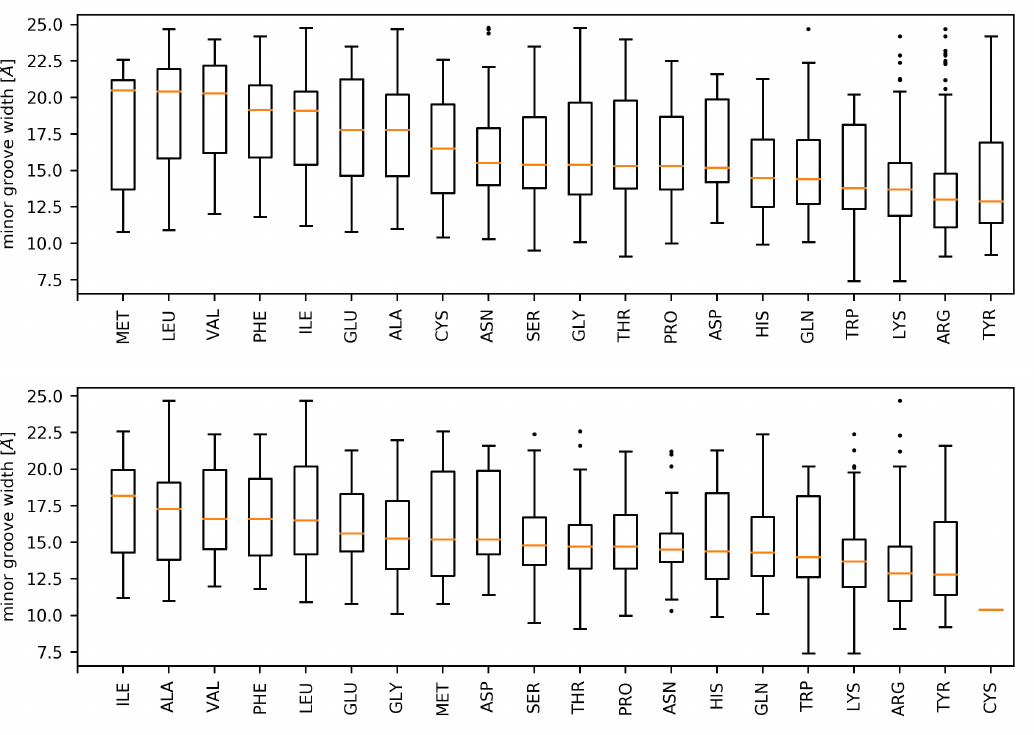
Figure 4. Distributions of DNA minor groove widths associated with the dinucleotides bound by the respective amino acids (top: DS1, bottom: DS2). Amino acids are sorted in descending order according to the associated median minor groove width. Whiskers of the boxplots denote the first and last 25% of the distributions. Maximal length of a whisker was set to 1.5 times the interquartile range. Any observations belonging to the whisker range that is further from the first/third quartile than this threshold is denoted as an outlier and marked as a dot in the